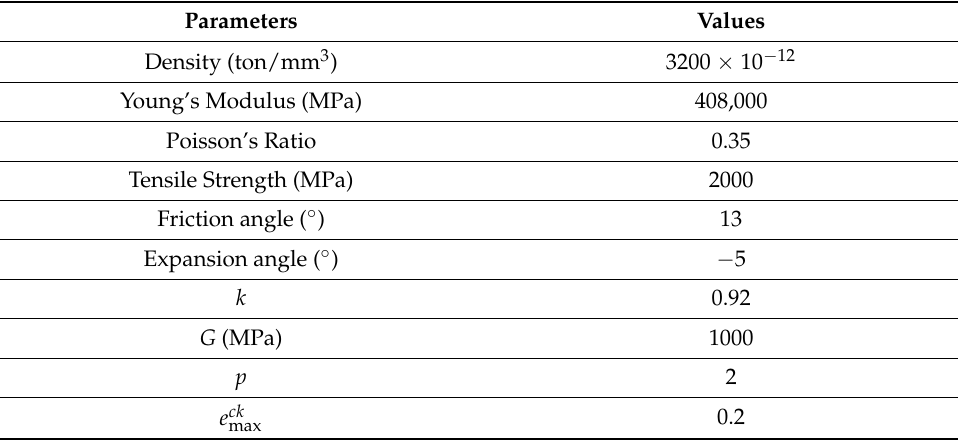
Table 3. Material properties and constants of SiC particles.